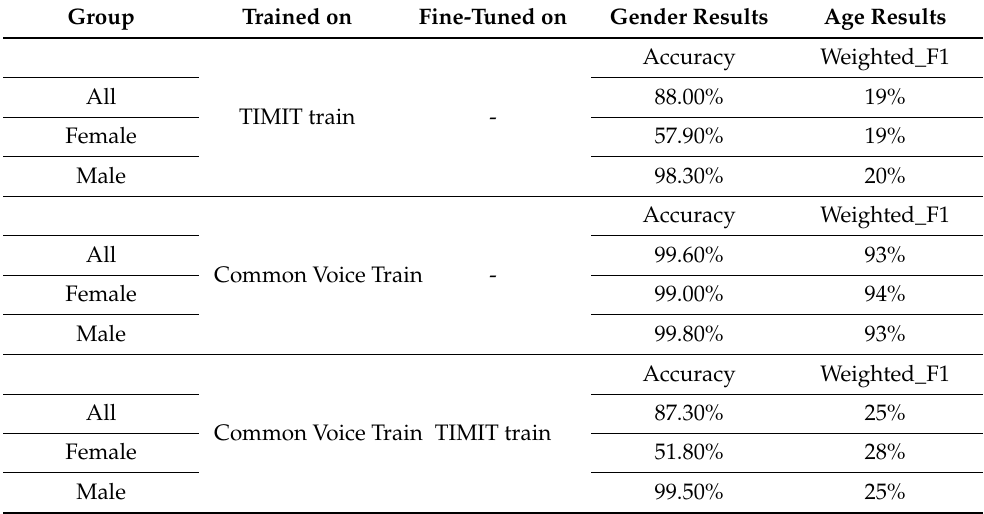
Table 13. Results on the Common Voice test set with a Quartznet-based x-vector embedder and volume